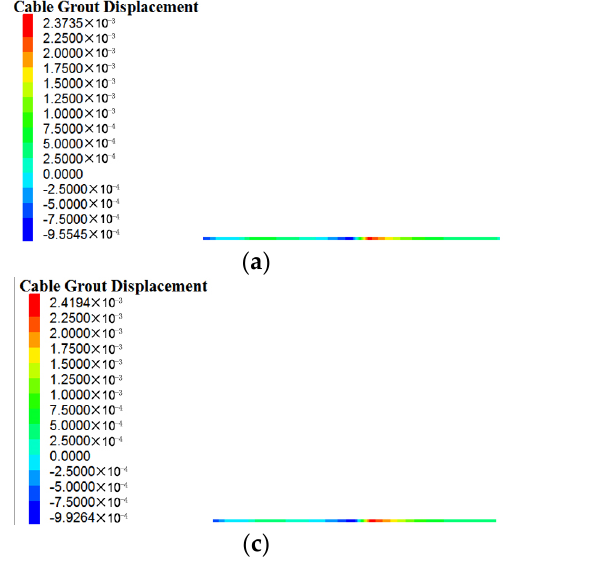
Figure 8. Cloud image of the cable grout displacement under di ff erent L a (with a fracture aperture of 4 mm). ( a ) L a = 400 mm; ( b ) L a = 600 mm; ( c ) L a = 800 mm; ( d ) L a = 900 mm.